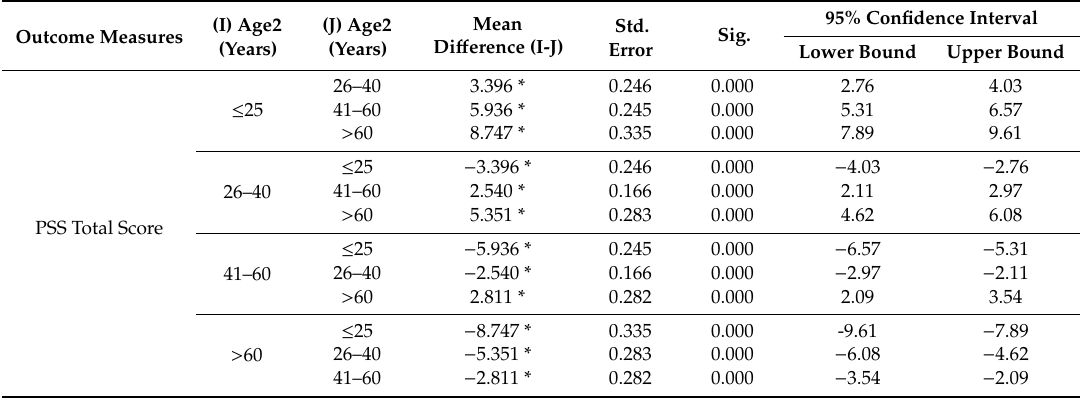
Table 4. Games-Howell post hoc multiple